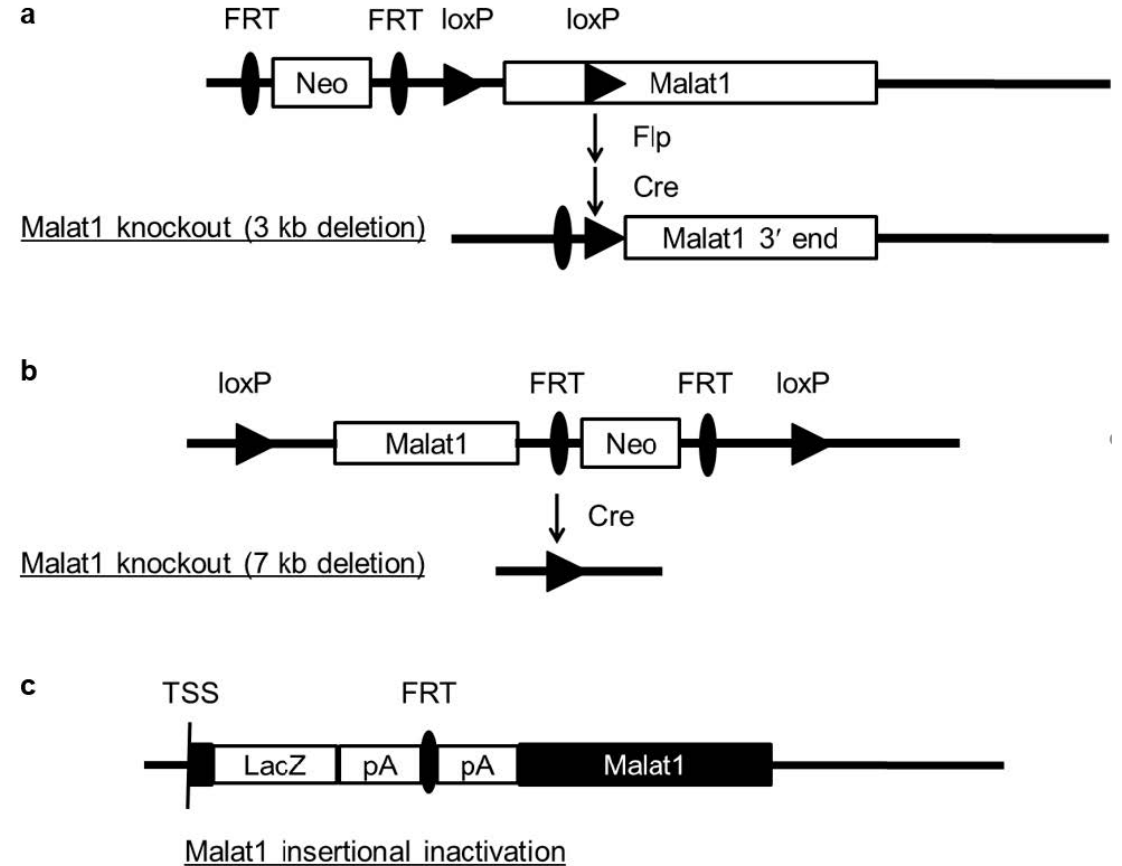
Figure 1. Different strategies used to generate Malat1 knockout mice. ( a ) A 3 kb genomic region encompassing the 5 ′ end of Malat1 and its promoter was deleted. ( b ) The full-length Malat1 , including 250 bp upstream of the transcriptional start site and 321 bp downstream of the 3 ′ end of Malat1 , was deleted. ( c ) The β -galactosidase gene ( lacZ ) with polyadenylation sequences (pA) was inserted 69 bp downstream of the transcriptional start site (TSS) of Malat1 .